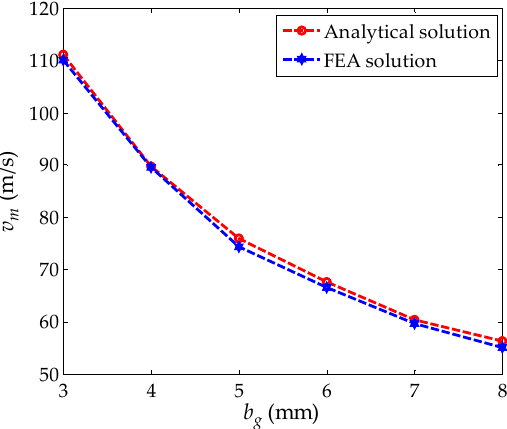
Figure 12. The critical speed varying with the induction plate thickness.